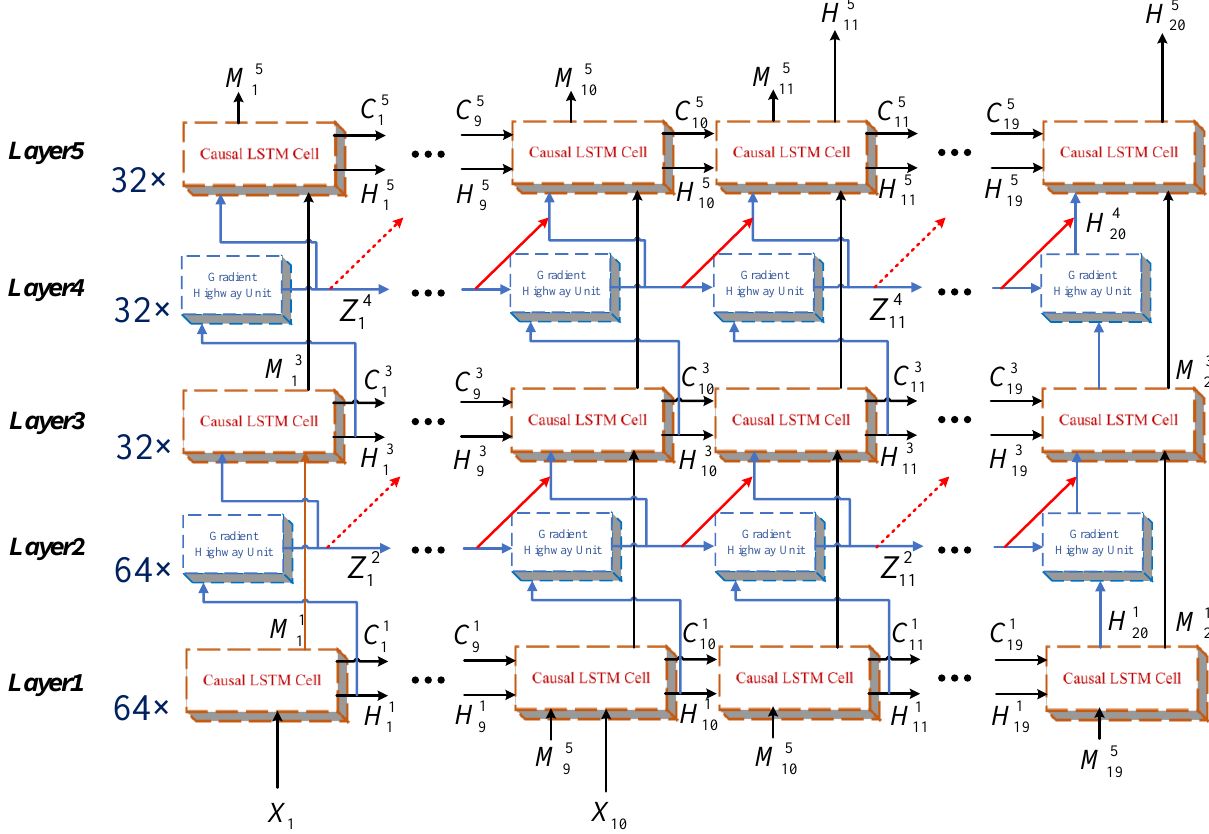
Figure 5. Schematic diagram of the CCLSTM structure. It contains a total of 20 longitudinal structure groups. (If the sequence length is changed, the number of structure groups will change accordingly.) The input is at the bottom of the first 10 groups, and the output is at the top of the last 10 groups. Groups 1, 10, 11 and 20 are shown here.